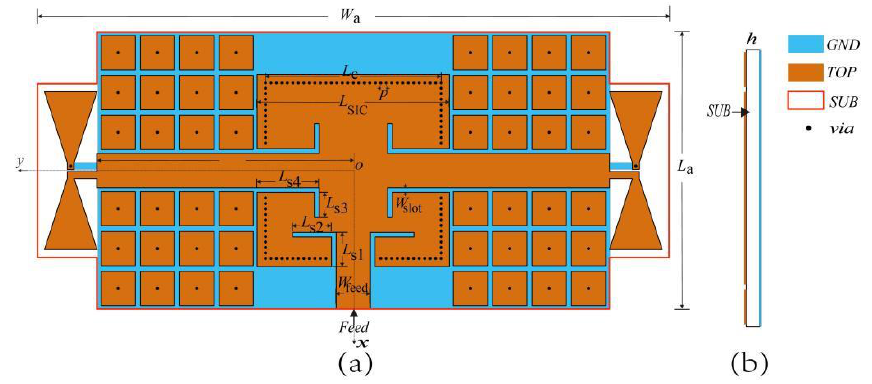
Figure 9. Geometry of the proposed metamaterial and SIC structure-based array antenna and the coordinate system. ( a ) Top view. ( b ) Side view.